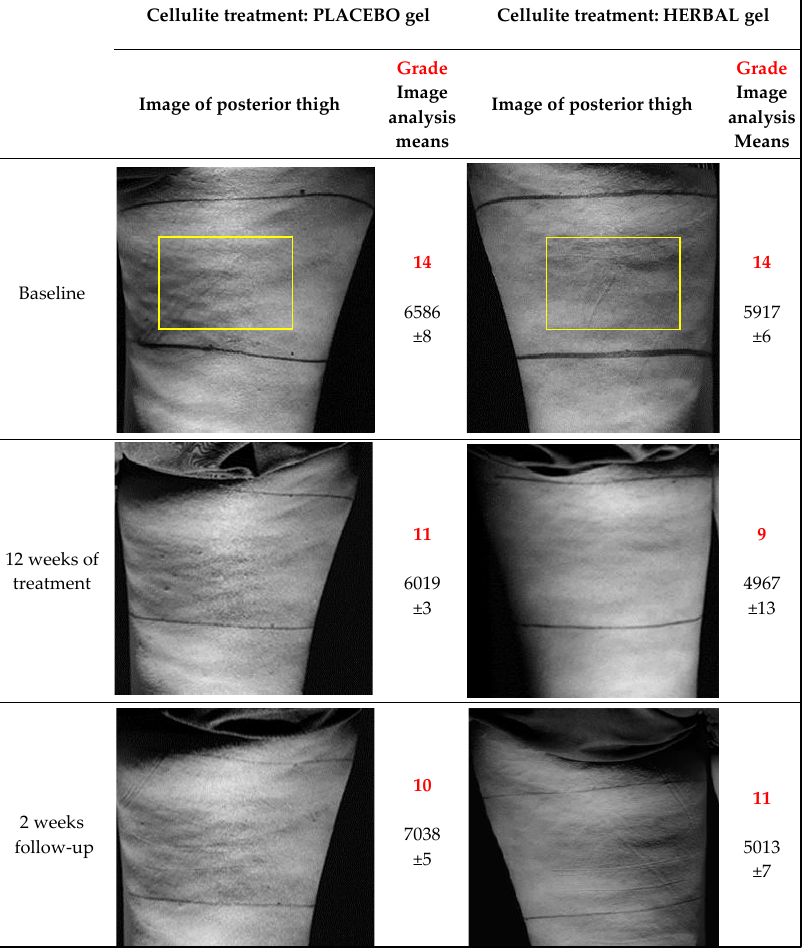
Figure 3. Representative photographs from a single participant showing thighs in posterior aspect as seen by three evaluators whose estimate is given as cellulite grades. The image analysis used the areas bounded by the yellow boxes and the unitless values were generated by three scans of each image to give means ± SEMs.